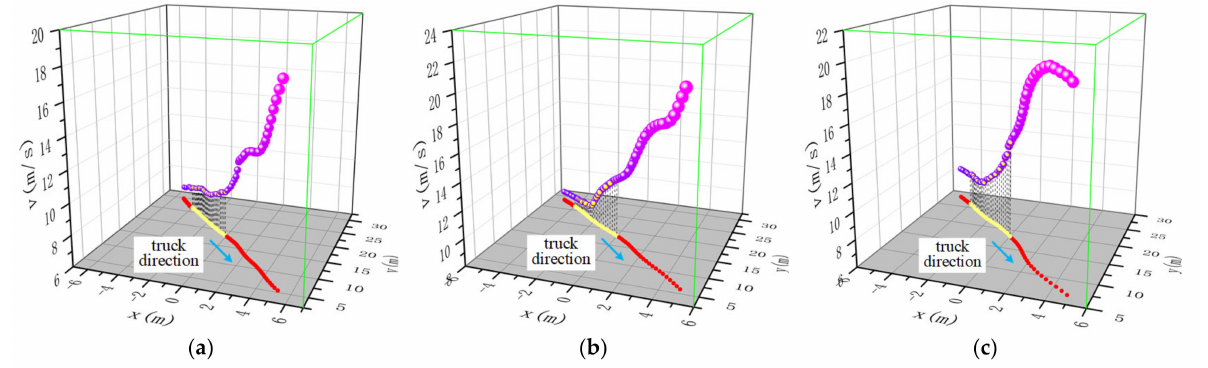
Figure 11. Steady state effect diagram. ( a )No.2; ( b ) No.5; ( c )